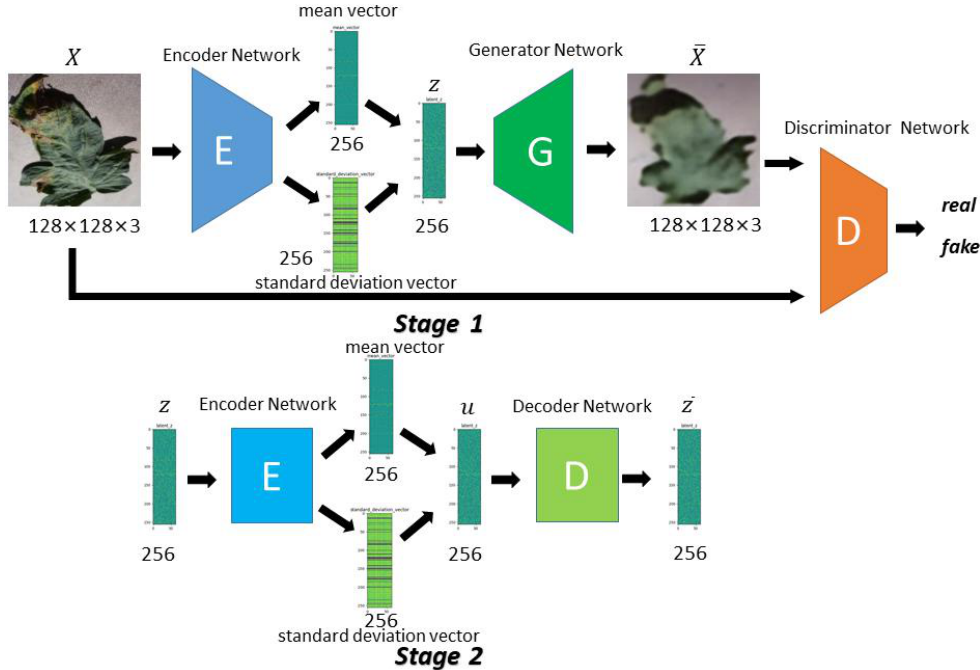
Figure 3. Structure of the Adversarial-VAE model.